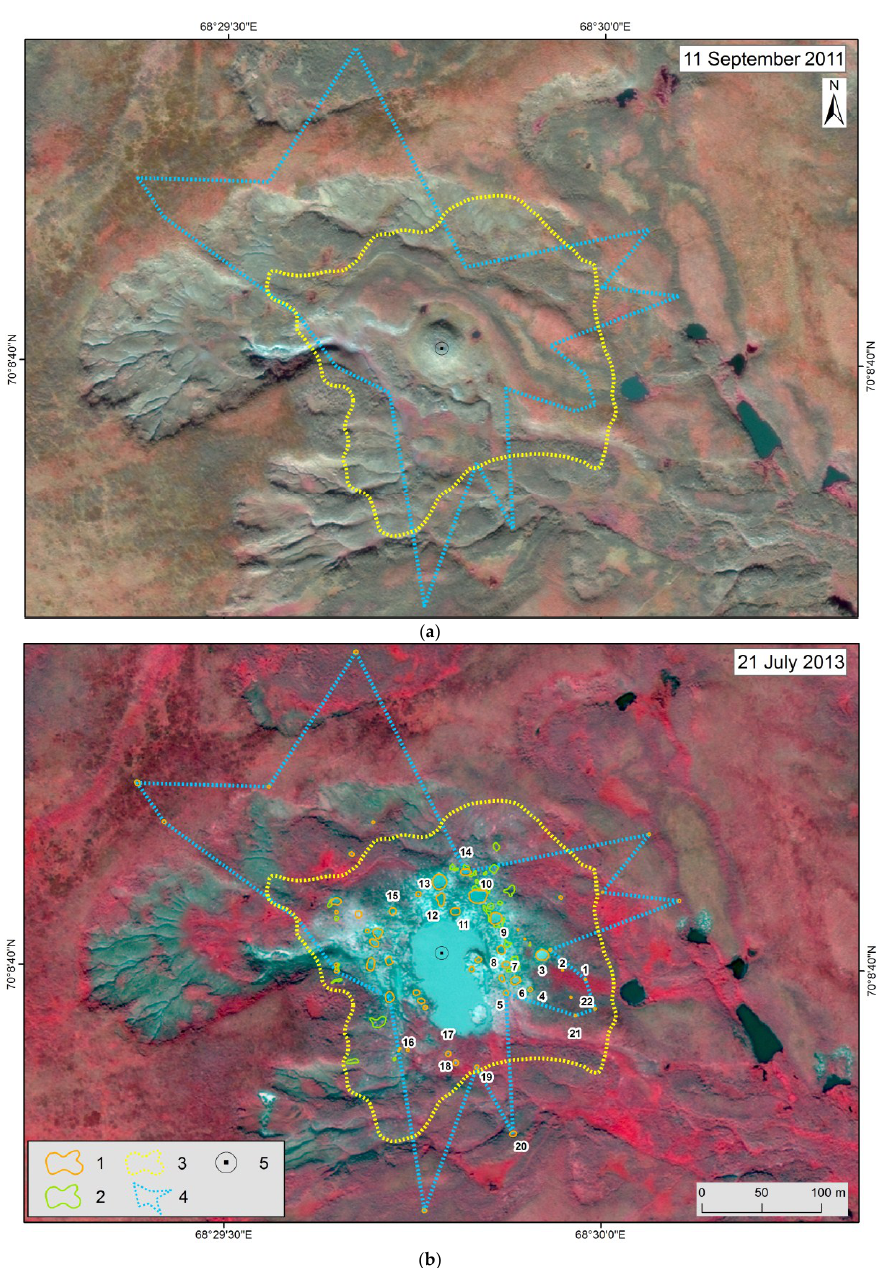
Figure 7. Location of impact hollows and accumulative piles around GEC-2. Allocated objects are marked on imagery characterizing the state of the surface of the key site: ( a ) before the formation of GEC-2 with a mound-predecessor on WorldView-2 image of 11 September 2011, synthesis of NIR + Red + Green; ( b ) with the existing GEC-2 on WorldView-2 of 21 July 2013, synthesis of NIR + Red + Green. Legend: 1, impact hollows; 2, agglomeration of ejected material or single piles; 3 and 4, scattering zones outlined on the basis of both field data and remote sensing data (RSD): 3, zone B; 4, zone A; 5, the apex of the mound-predecessor of GEC-2. Numbers indicate the impact hollows allocated on imagery and reliably correlated with the blocks of icy deposits in the photograph from the helicopter (Figure 4) with exception of those destroyed due to the retreat of the crater walls and subsequent flooding by the expanding crater